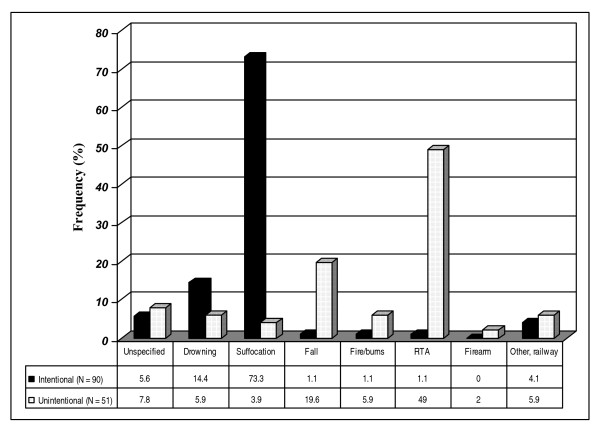
FIUI mechanisms.